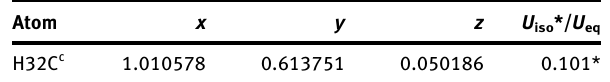
Table  : Fractional atomic coordinates and isotropic or equivalent isotropic displacement parameters (Å 